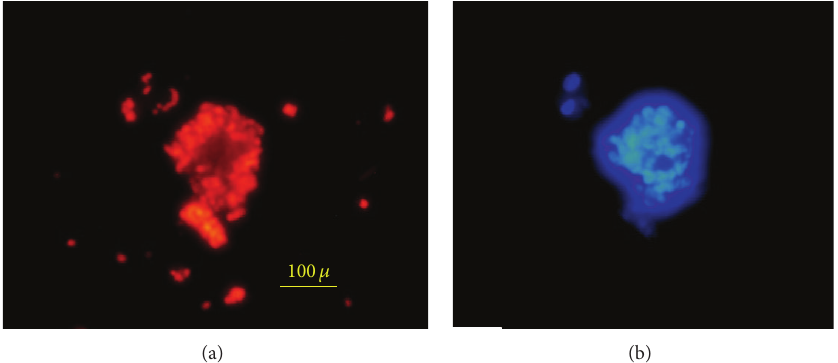
Figure 6: A neurosphere stained with anti-nestin-Alexa Flour 568 (red) antibody (a) and DAPI (b).